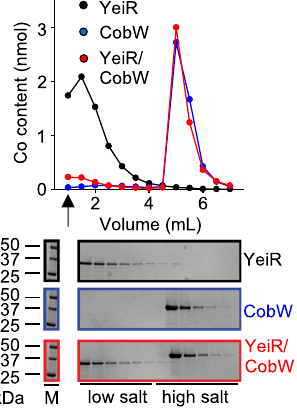
Fig. 7 Mg II GTP-CobW outcompetes Mg II GTP-YeiR for Co II . Elution pro fi le of YeiR (10 μ M), CobW (10 μ M) or both proteins following incubation with